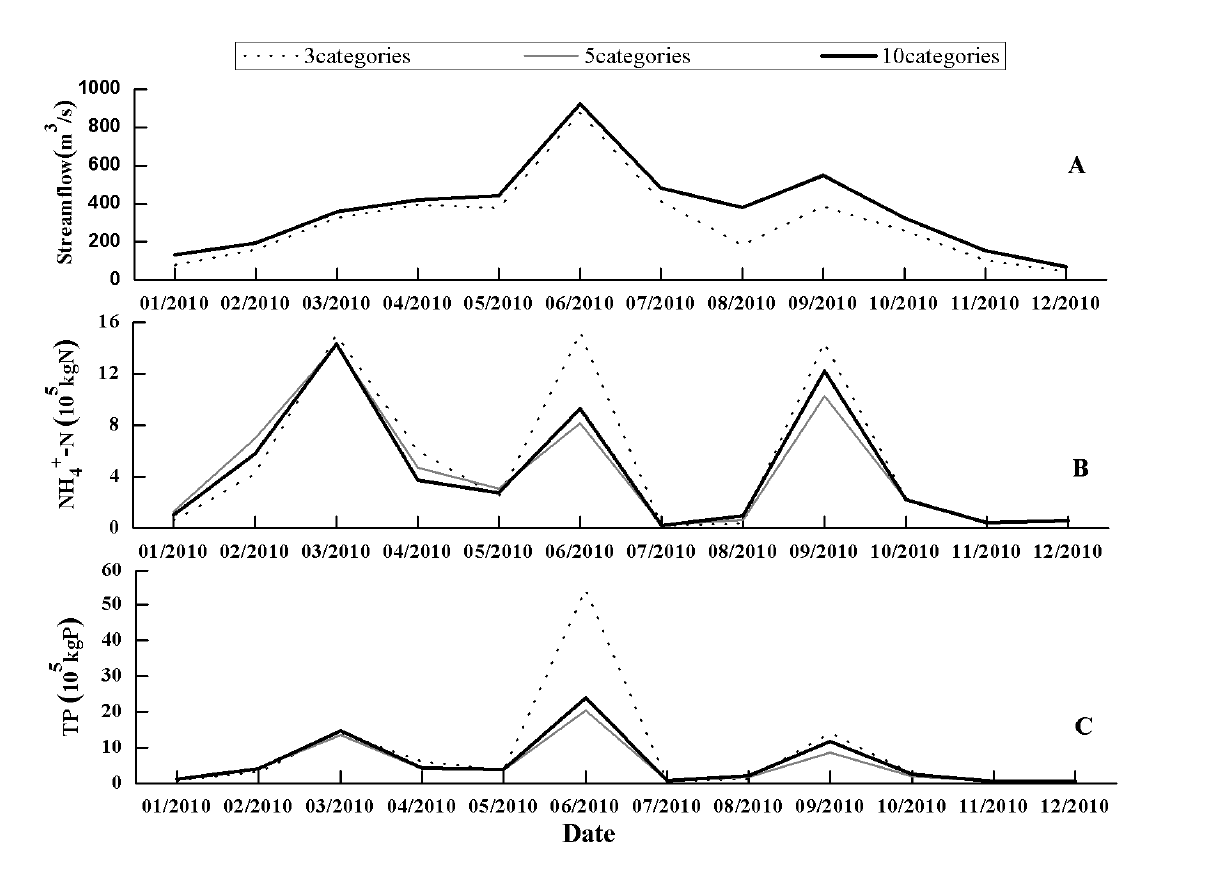
Figure 4. Comparisons among monthly streamflow ( A ), NH predicted when using LULC datasets with three levels of